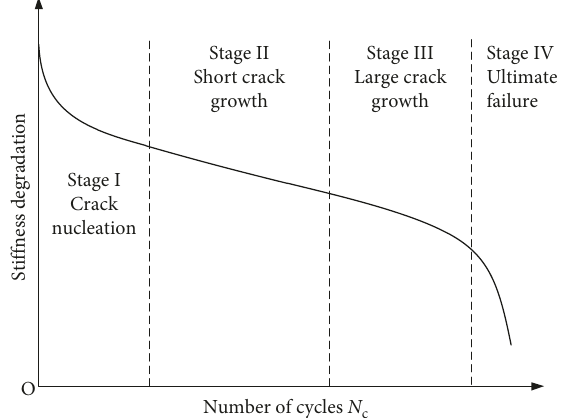
Figure 9: The four stages of the fatigue failure process [16].